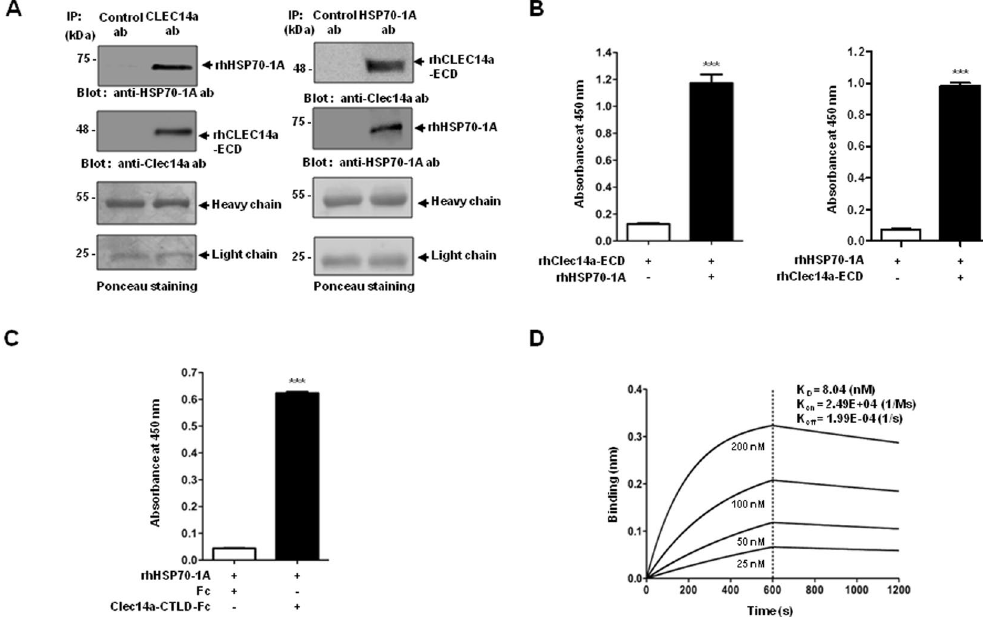
Figure 3. Specific interaction of HSP70-1A with CLEC14a. ( A ) Co-immunoprecipitation with purified rhHSP70-1A or rhCLEC14a-ECD was performed to measure the binding of rhCLEC14a-ECD to rhHSP70-1A (left) or of rhHSP70-1A to rhCLEC14a-ECD (right), respectively. The heavy and light chains of the control antibody, anti-CLEC14a antibody or anti-HSP70-1A antibody were used as a loading control and were stained with Ponceau stain. ( B ) ELISA with purified rhHSP70-1A or rhCLEC14a-ECD was performed to measure the binding of rhHSP70-1A to rhCLEC14a-ECD (left) or of rhCLEC14a-ECD to rhHSP70-1A (right), respectively. ( C ) The bindings of CLEC14a-CTLD-Fc, or Fc to rhHSP70-1A were measured by ELISA. Data are represented as the mean ± SEM of triplicate measurements from two independent experiments; *** P < 0.001. ( D ) The binding affinity of rhHSP70-1A to rhCLEC14a-ECD was measured by a biolayer interferometry assay using an Octet ® RED96 system. K D = equilibrium dissociation constant; K on = association rate constant; and K off = dissociation rate